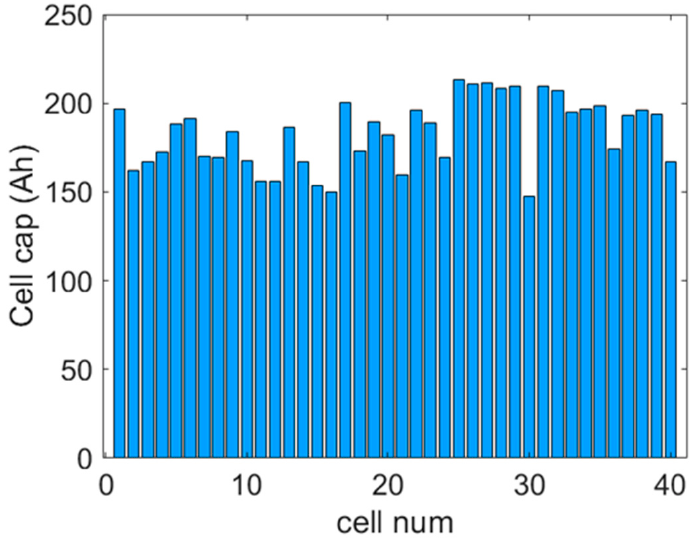
Figure 2. Interface capacity of retired LFP batteries.